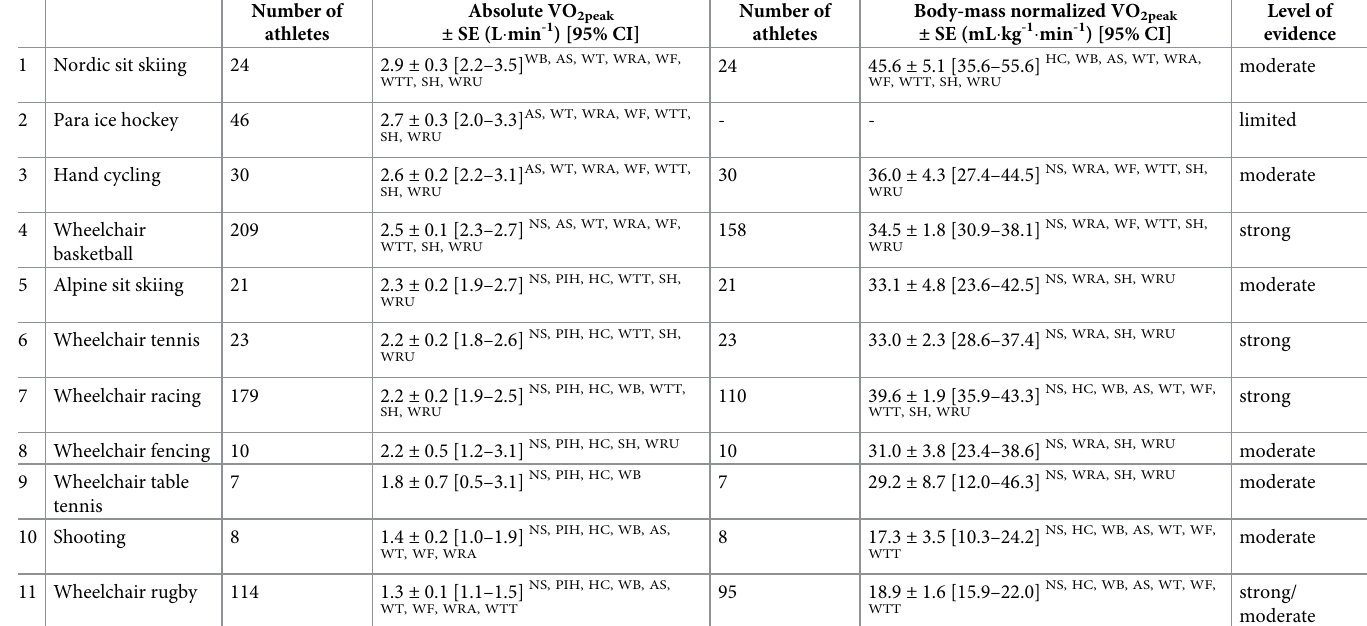
Table 2. Overview of absolute and body-mass normalized peak oxygen uptake (VO 2peak ) (mean ± SE [95% CI]) and level of evidence within the separate sitting sports disciplines. Sports disciplines are presented in order of absolute VO 2peak values, from high to